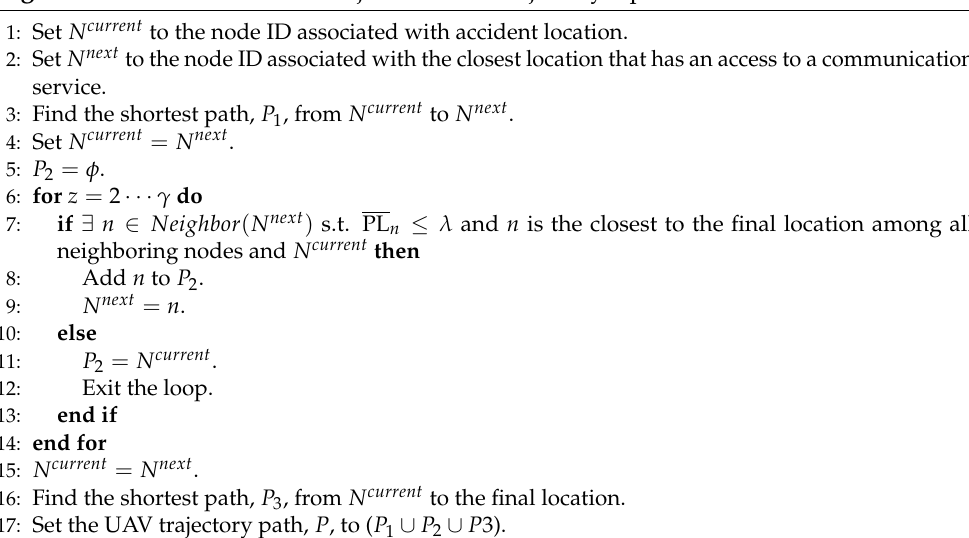
Algorithm 1 Prioritized Multi-objective UAV Trajectory